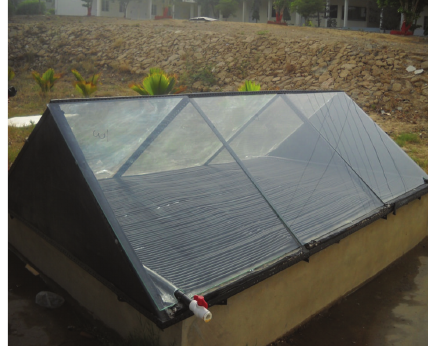
Figure 7: Final assembly of DSTEC.